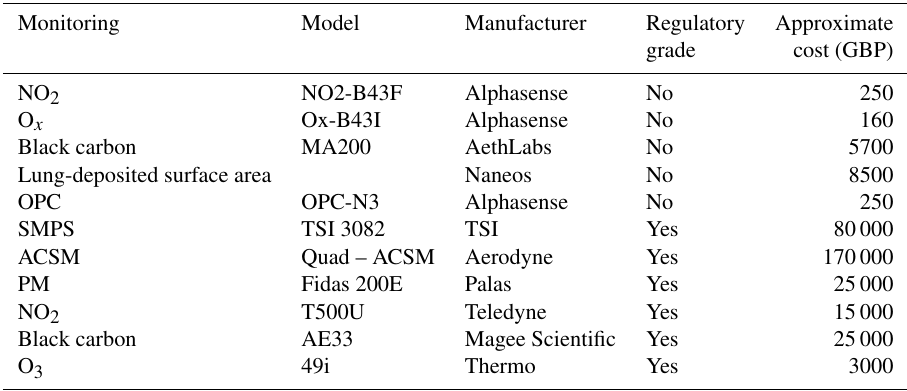
Table 1. List of the measuring instruments used in the present study. Monitoring